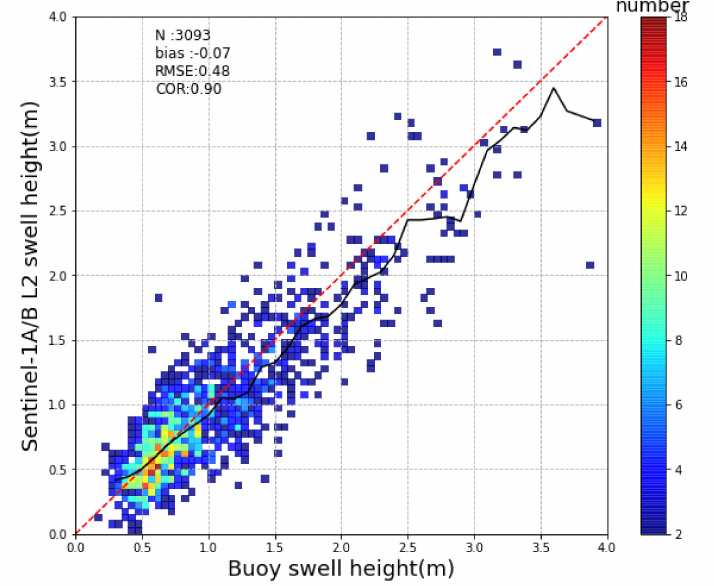
Figure 14. As in Figure 10, but after